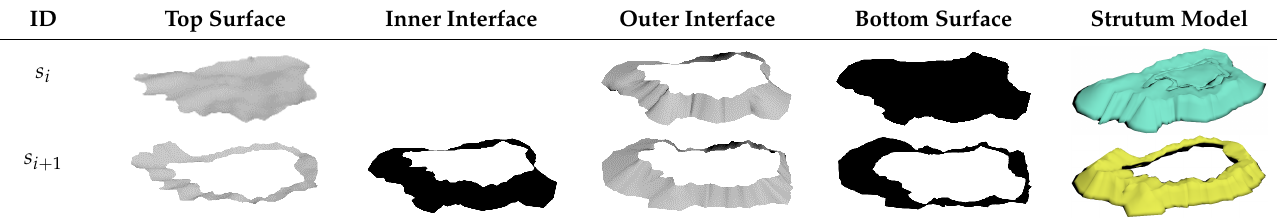
Table 4. Stitching of all sides of strata. Top